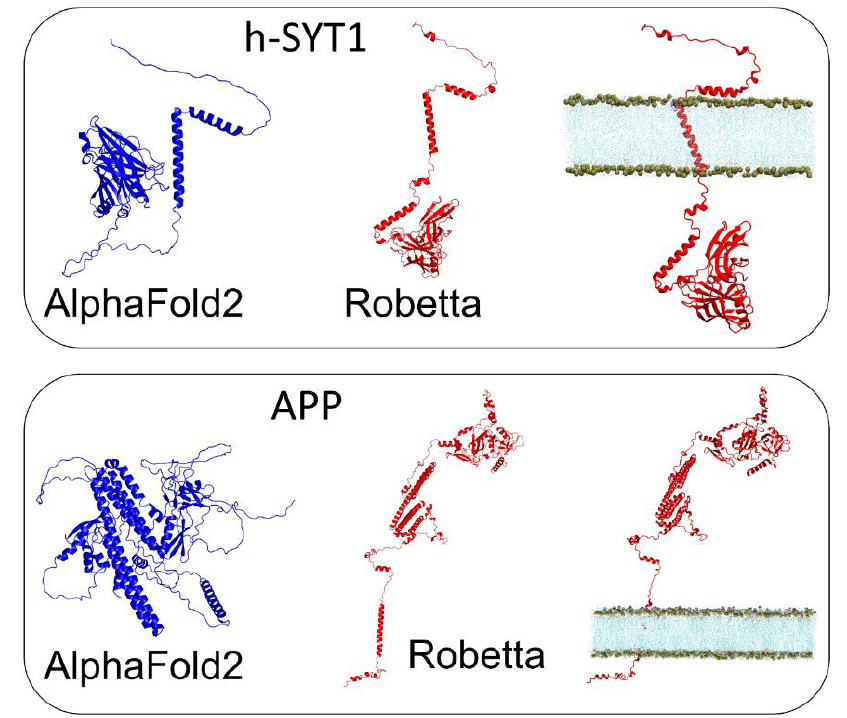
Figure 4. Comparison of the structure of human synaptotagmin 1 (h-SYT1) ( top panel ) and APP ( bottom panel ) retrieved from AlphaFold2 (blue) or generated by ab-initio modeling with Robetta (red).